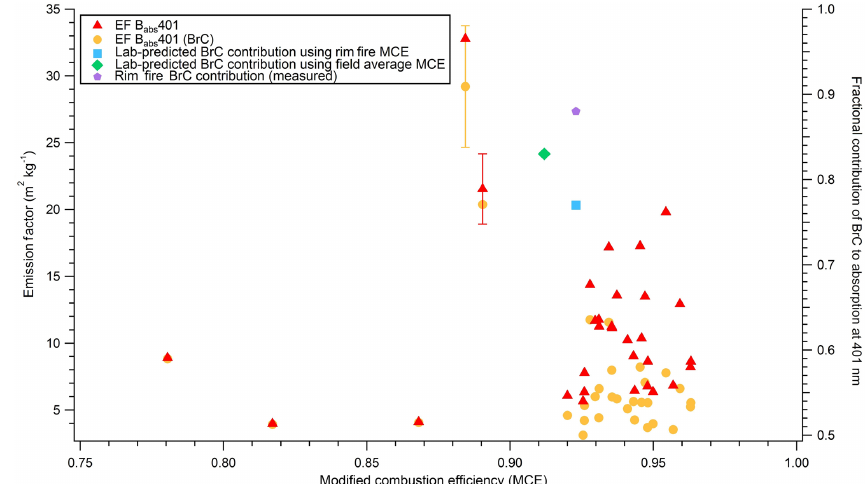
Figure 8. Absorption emission factors measured at 401nm for “BC plus BrC” and for “BrC only” for 31 lab fires, Also shown are the fractional contributions of BrC to total absorption at 401nm predicted from the lab AAE data at the field-average MCE (green), the Rim Fire MCE (blue), and the field-measured AAE (purple) (Forrister et al., 2015; Liu et al.,